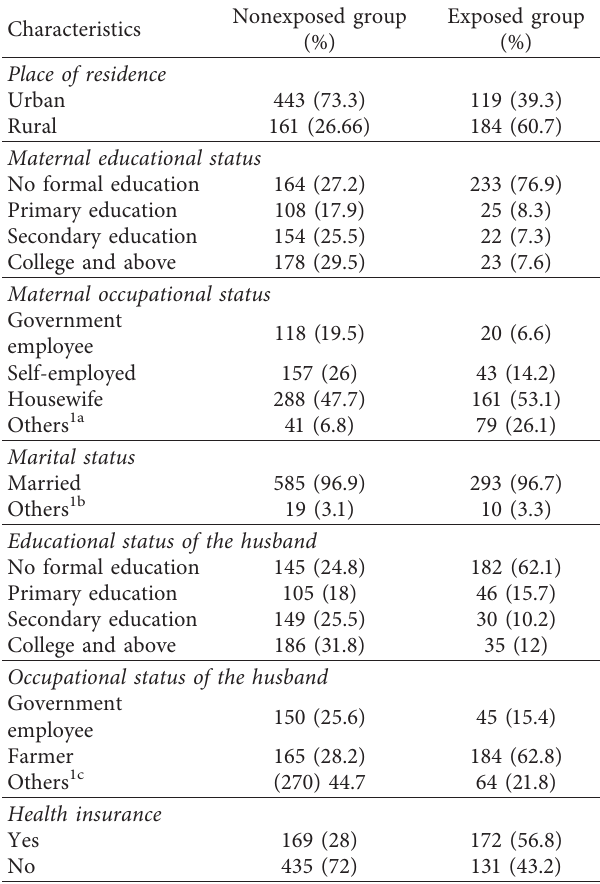
Table 1: Distribution of sociodemographic characteristics over grouped maternal age in Debre Markos referral hospital, Northwest Ethiopia, 2019 ( N E � 303 and N Ne �